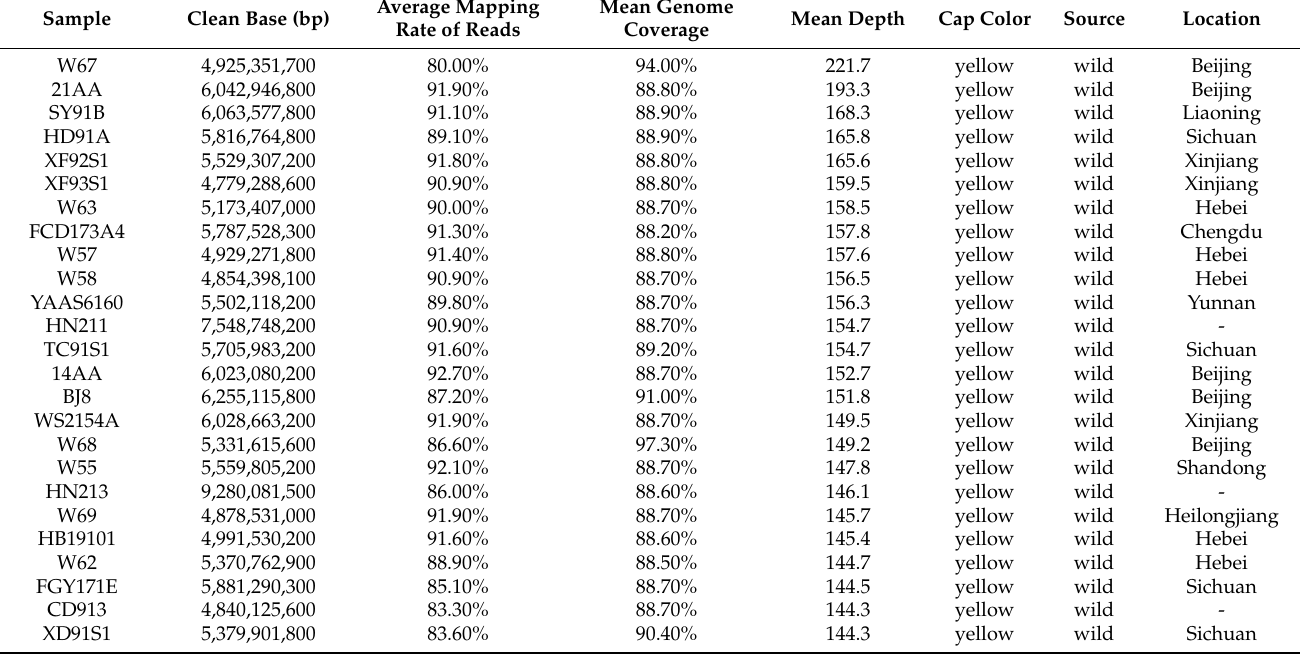
Table 1. The basic information of whole genome sequenced